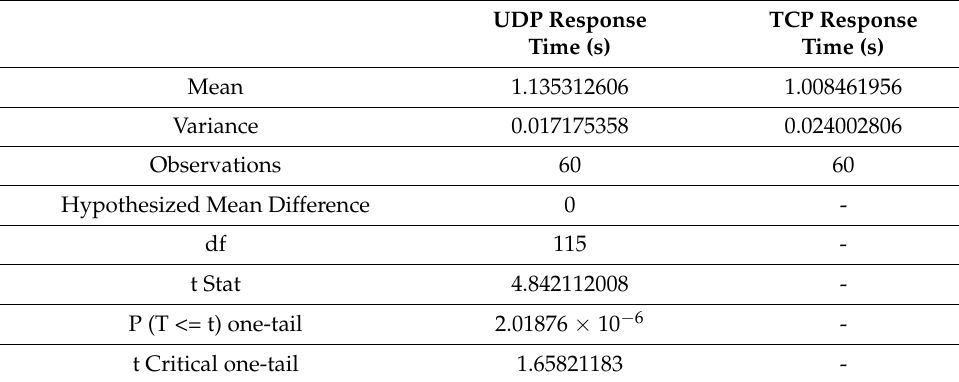
Table 8. Results, Experiment 5.